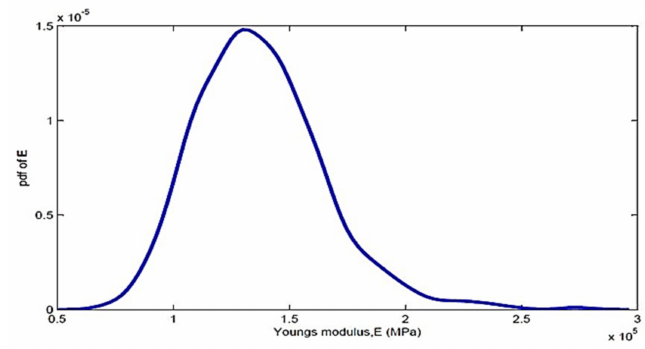
Figure 12. Young’s modulus due to the variation of the material properties.